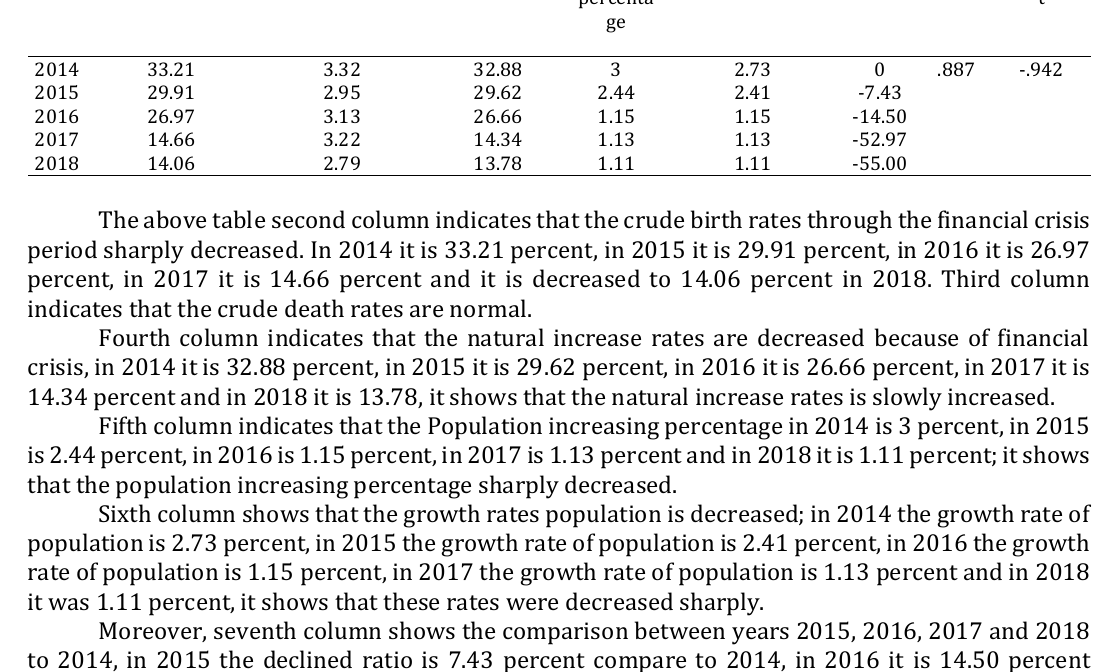
Birth R 2 (R Pearson decline square Correlati d rate ) on Coefficien